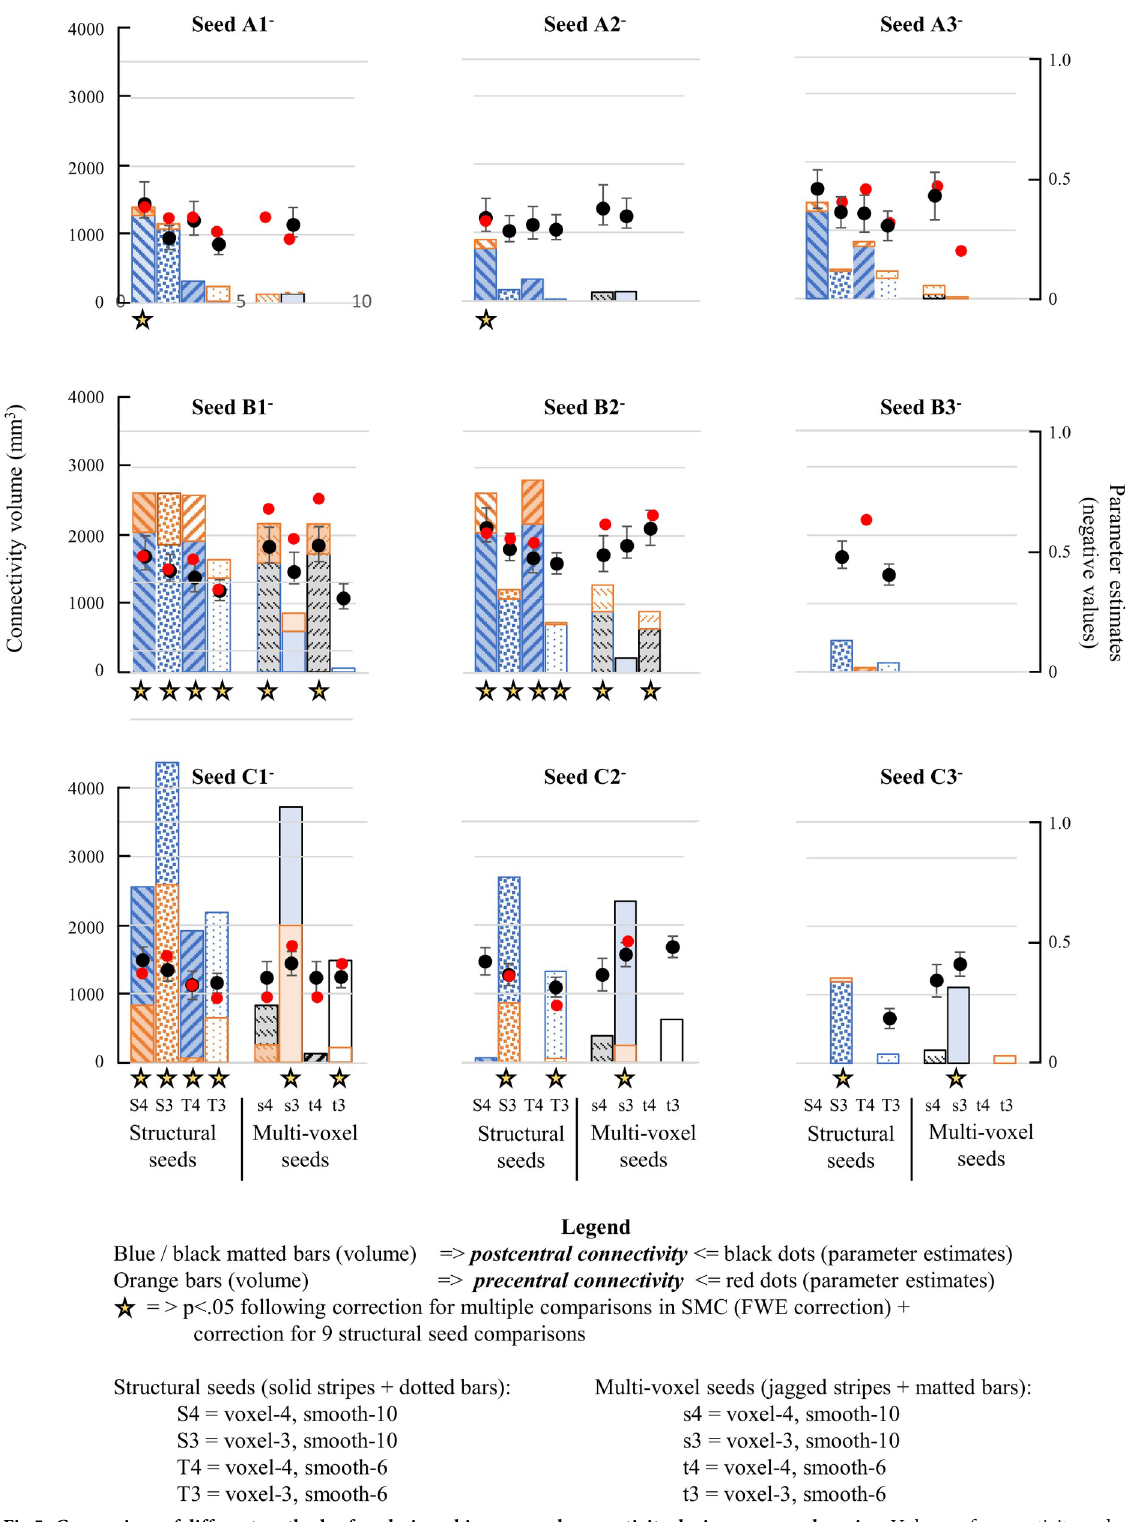
Fig 5. Comparison of different methods of analysis on hippocampal connectivity during sequence learning. Volume of connectivity and mean beta parameter estimates from eight methods of analysis at each region identified for structural seeds. Larger volumes of connectivity were elicited from structural seeds, particularly in medial (left) and posterior regions (bottom, see especially C1). Larger connectivity volumes